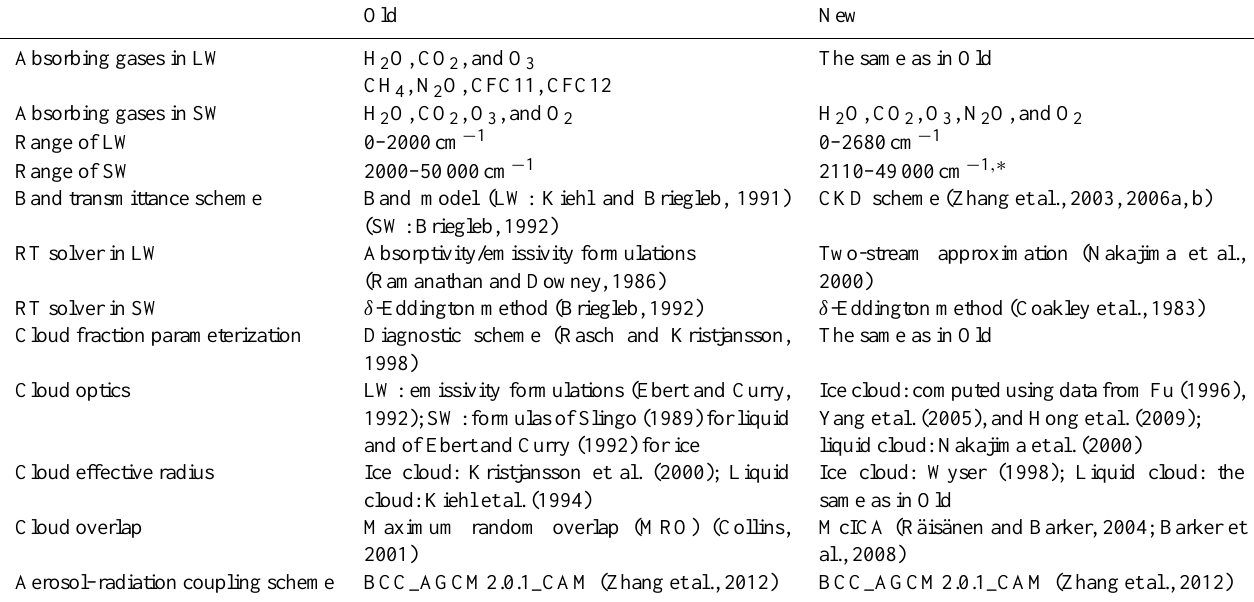
Cloud effective